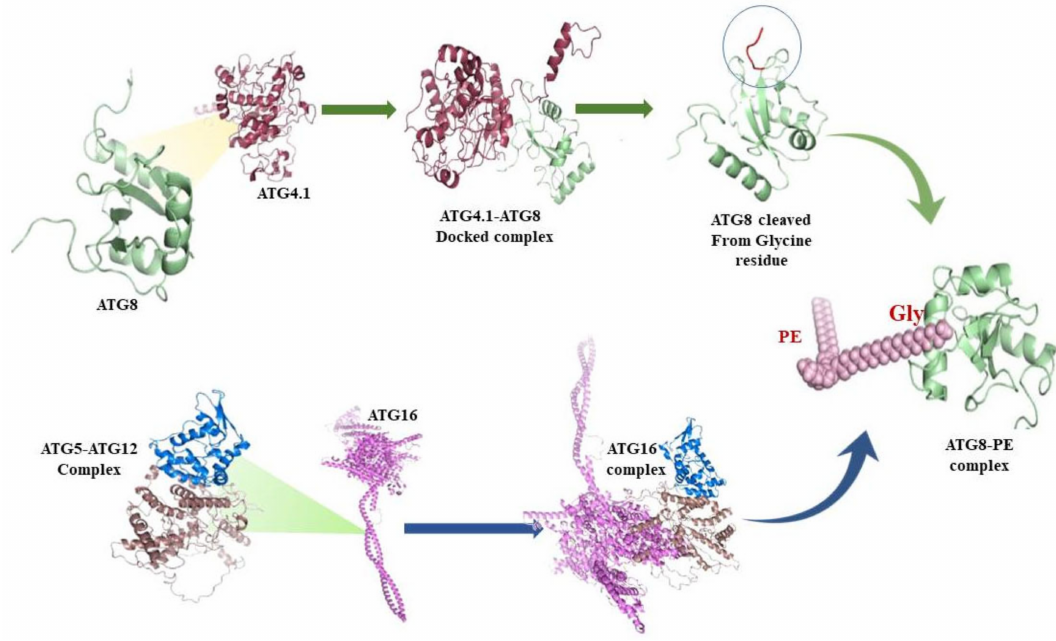
Figure 6. Autophagic proteins interacting with each other in different stages of autophagosome formation in Leishmania major .